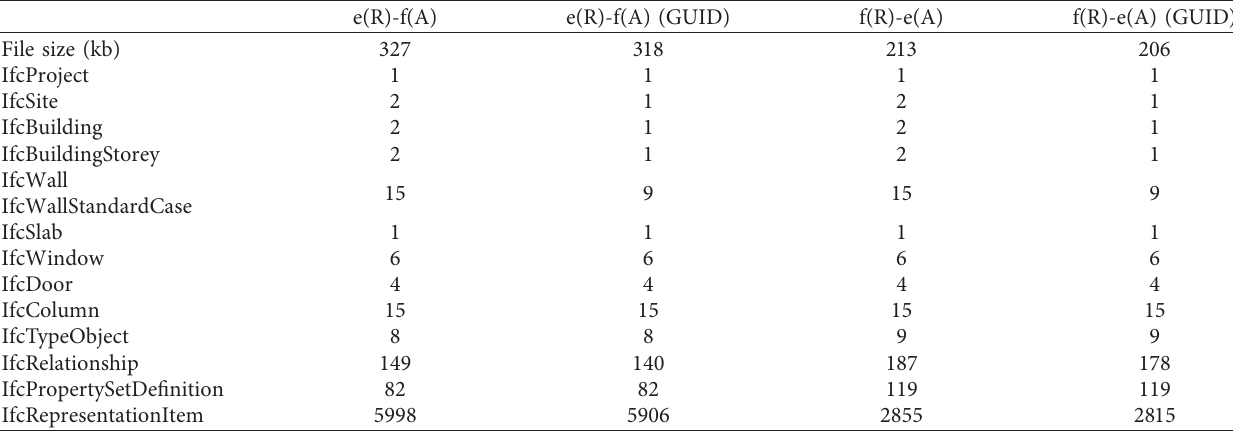
Table 6: Entity statistics for scenarios e and f in different modeling